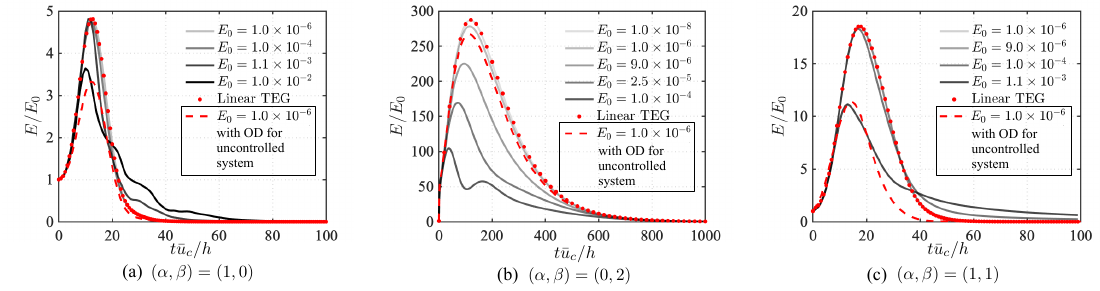
Figure 12. Transient energy growth (TEG) of optimal disturbance with a range of initial kinetic energy densities E 0 from linear (red dots) and nonlinear (solid lines) simulations for controlled flows: Red dashed line is the kinetic energy density initialized from the optimal disturbance (OD) associated with the uncontrolled